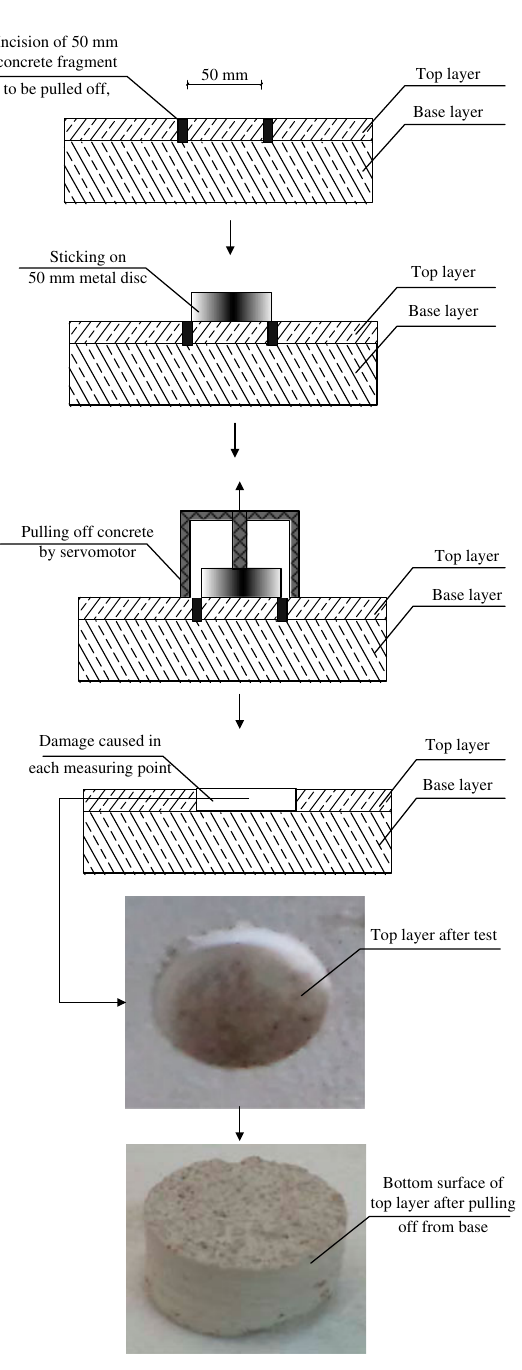
Fig. 1. Sequence showing how floor top concrete layer is damaged by pulling off f 50 mm piece of it from base, using semi-non-destructive